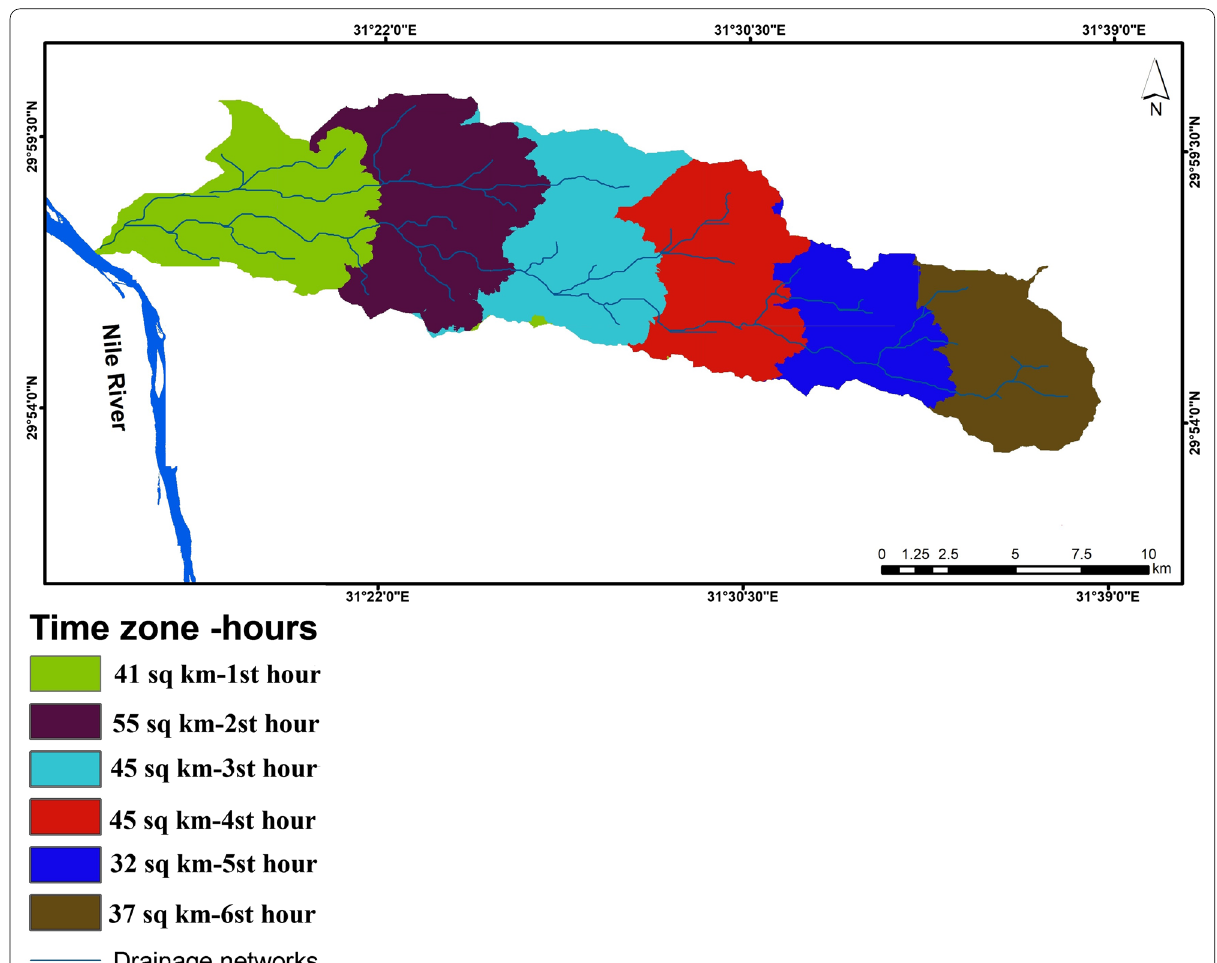
Fig. 7 The estimated time-area cascading zones for the catchment. The GIS spatially distributed unit hydrograph was then estimated given the estimation of effective rainfall routed from these zones to the outlet